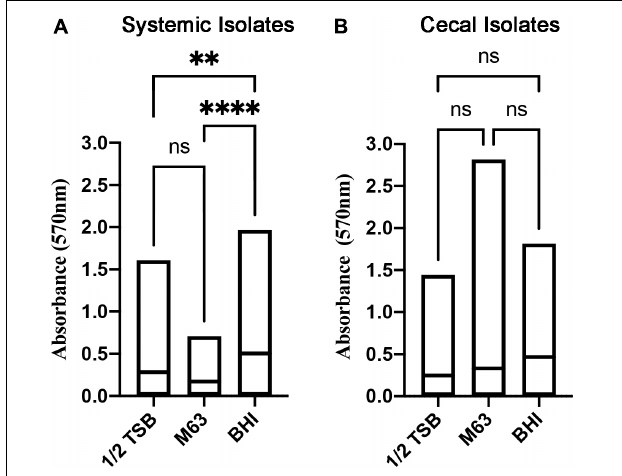
FIGURE 1 | Quantitation of biofilm biomass for systemic and cecal E. coli isolates grown in three different growth media. Bars represent the mean absorbance of dissolved crystal violet that was used to stain biofilm cells and extracellular matrix from 56 systemic E. coli (A) or 38 cecal E. coli (B) . Statistical significance between different growth media was tested by one-way ANOVA ( ∗∗∗∗ p < 0.0001; ∗∗ p < 0.01; ns, p > 0.05).